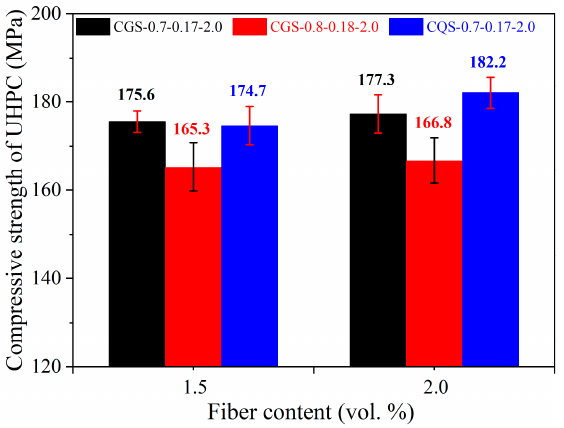
Figure 7. The compressive strength of the